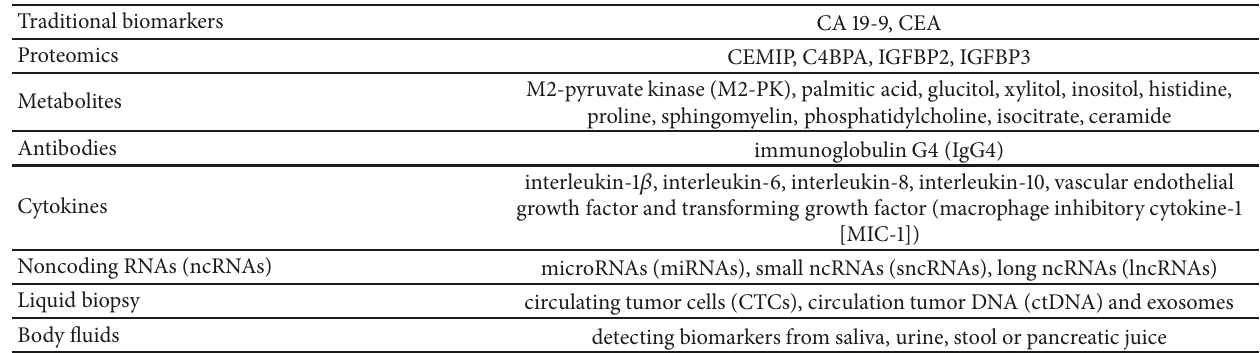
Figure 1: Characteristics required for biomarkers of pancreatic cancer. Table 1: Overview of biomarkers of early pancreatic